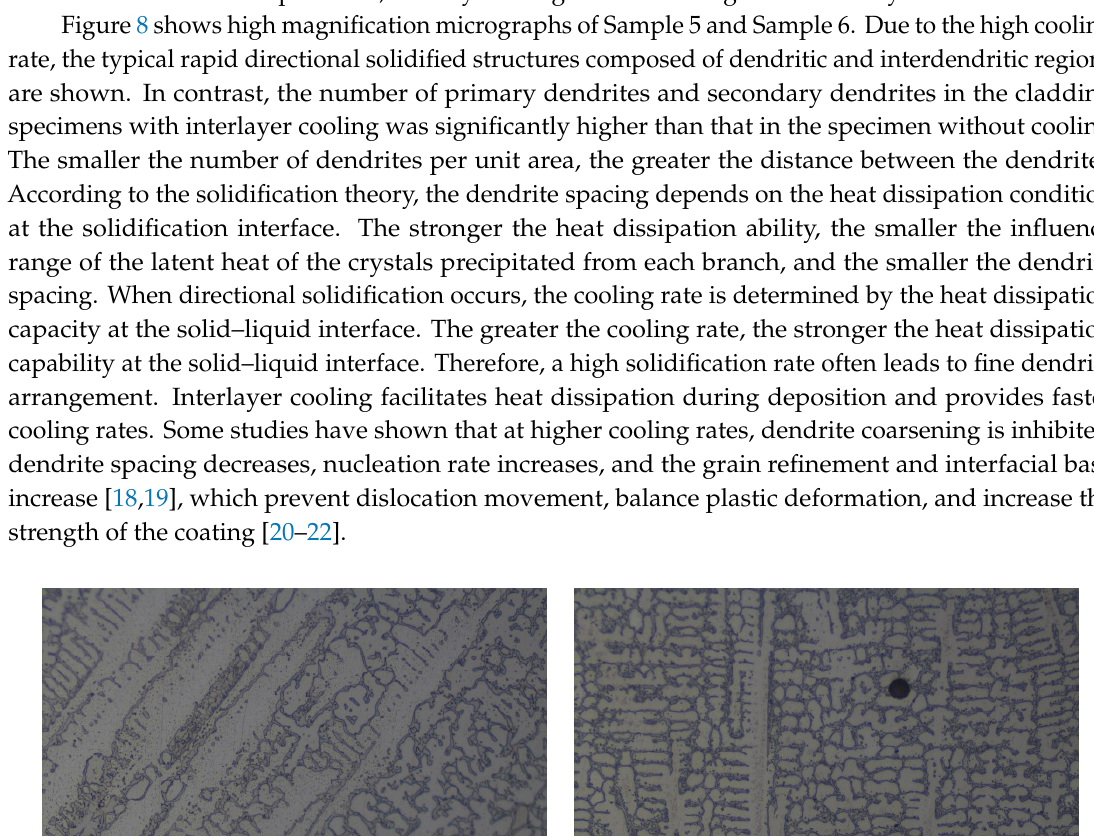
Figure 9. SEM image of cross-section morphology of Sample 5 coating. To further determine the composition, six sets of specimens were analyzed by XRD, as shown in Figure 11. Sharp and broad peaks were observed, which corresponded to the γ and γ’ phase of the Ni-base solid solution. Ni 3 B phase and some other compounds of Ni were observed in Samples 1 and 2. Combined with the XRD pattern of the powder (Figure 3b), it may be due to insufficient laser power, resulting in more Ni3B residue powder in the coatings. At the same time, NiC x was created. From the XRD results, no significant intermetallic oxides were observed due to the low volume fraction. The grain sizes of in Figure 11 were calculated by Scheler’s formula. The grain sizes of samples 1–6 are 33.2, 28.7, 56.7, 36.9, more than 100 and 39.5 nm, respectively. By comparing Samples 1, 3, and 5 or Samples 2, 4, and 6, we can find that the grain sizes of the sample increase with the increase of laser power. This is due to the temperature of molten pool increasing with the increase of laser power. However, there is no obvious difference in the increase of grain sizes of the samples with interlayer